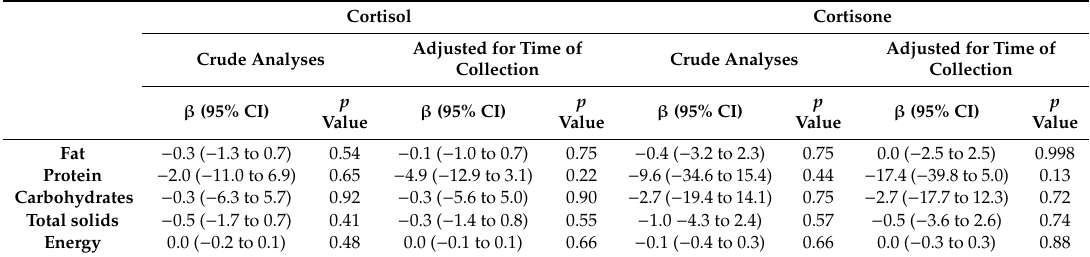
Table 2. Associations between milk glucocorticoids and macronutrients. Cortisol Cortisone Adjusted for Time of Adjusted for Time of Crude Analyses Crude Analyses Collection